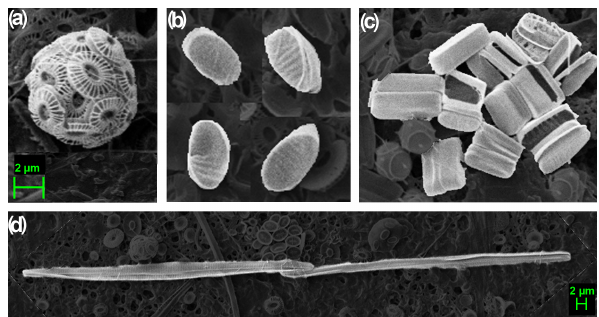
Figure 4. SEM images of the four phytoplankton species identified by the SIMPER analysis as characterizing the significantly differ- ent community structures: (a) E. huxleyi , (b) F. pseudonana , (c) F. nana , and (d) Pseudo-nitzschia